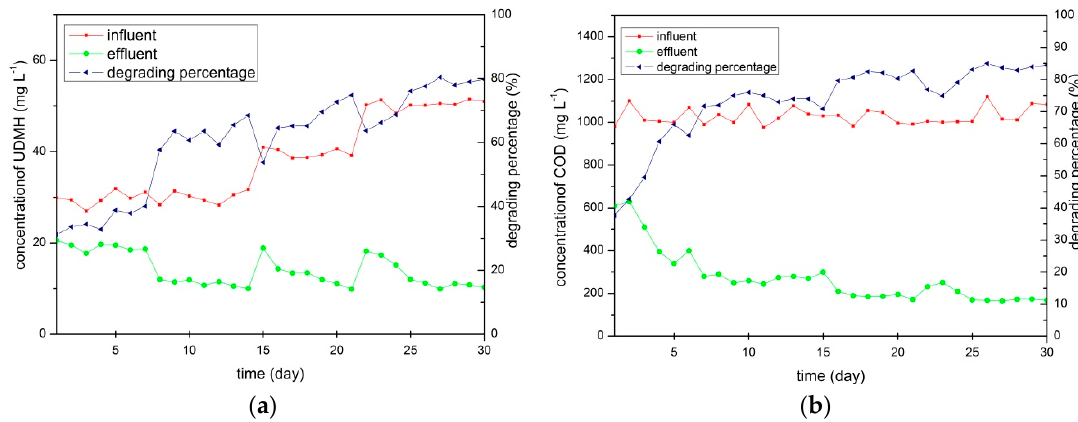
Figure 1. The degradation of unsymmetrical dimethylhydrazine (UDMH) by activated sludge: ( a ) the removal of UDMH; ( b ) the removal of chemical oxygen demand (COD).